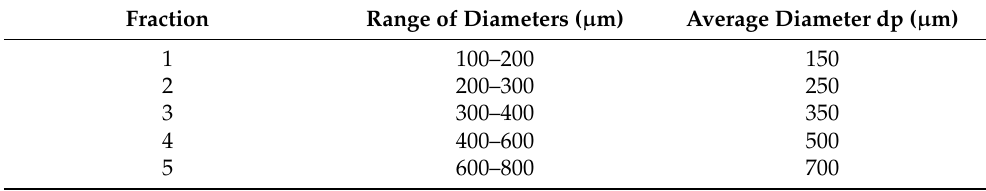
Table 1. Range of microspheres diameters (given by producer Alumetal-Technik).